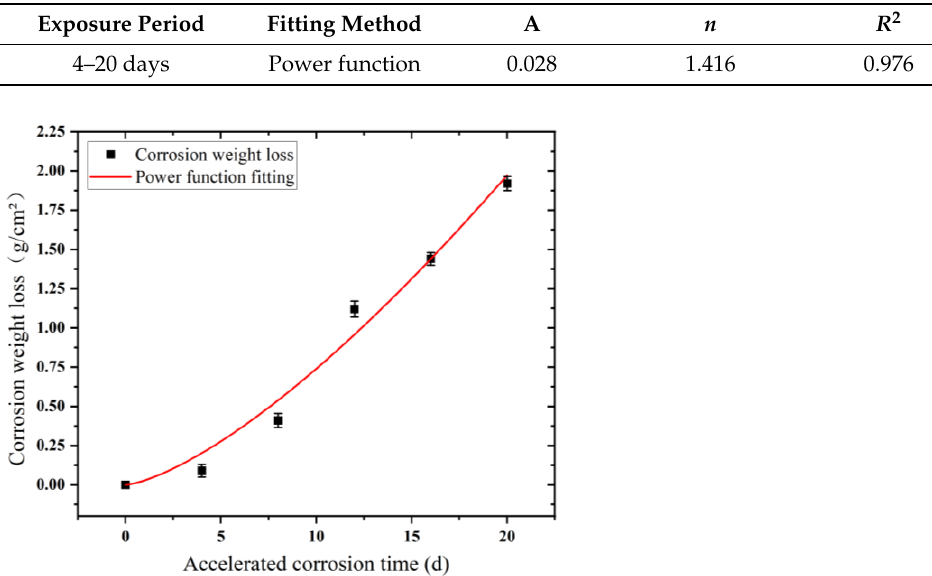
Figure 12. Corrosion kinetic analysis of Q235 low-carbon steel samples in an accelerated corrosive environment. Table 2. Corrosion weight loss fitting results of Q235 low-carbon steel samples exposed to accelerated corrosive environments.